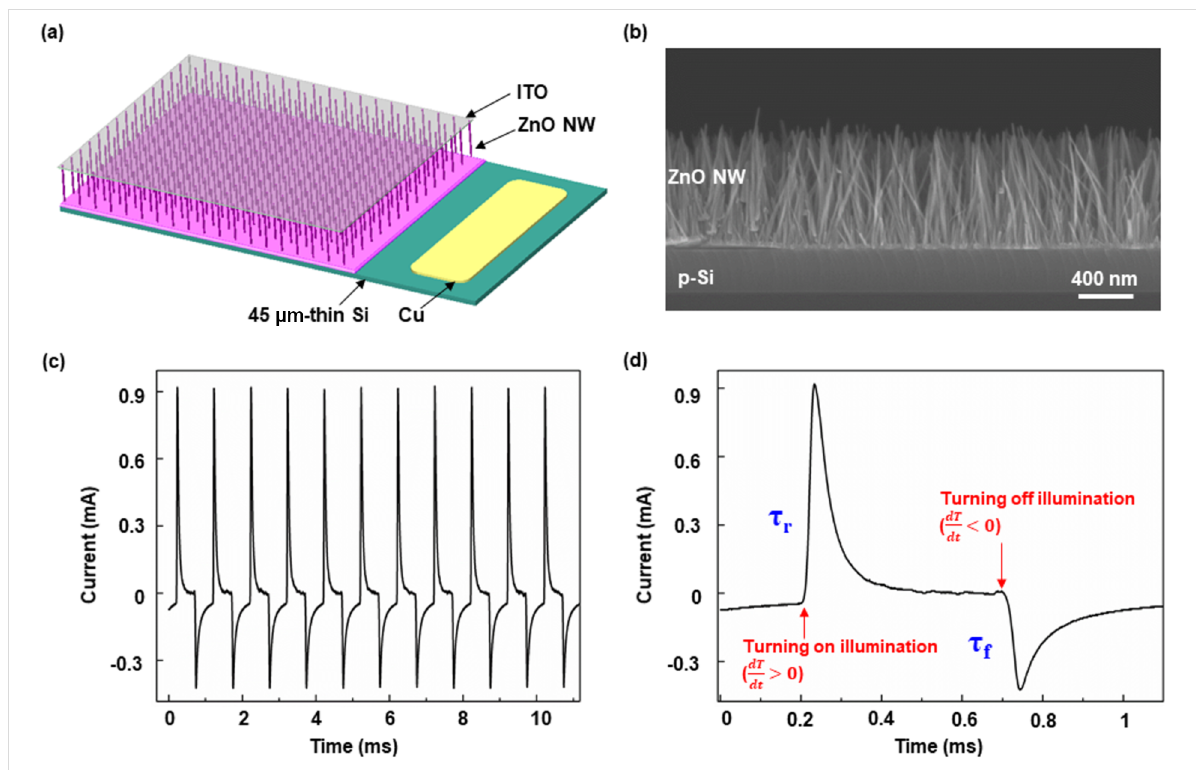
Figure 1: (a) Structure diagram of p-Si/n-ZnO NWs PDs. (b) Cross-sectional SEM image of the as-grown Si/ZnO NWs heterojunction. (c) Dynamic response curve I–t under 325 nm ultraviolet illumination and zero bias. (d) One typical cycle of short-circuit I–t curve.